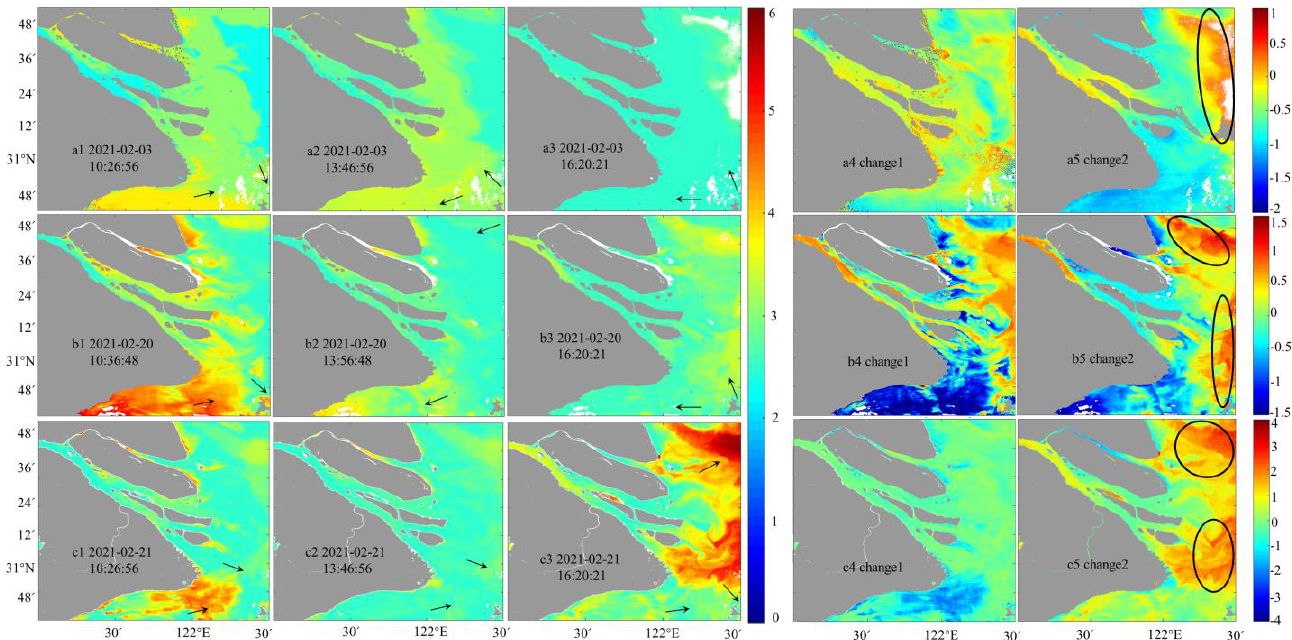
Figure 8. ( a1 – c1 ), ( a2 – c2 ), ( a3 – c3 ), ( a4 – c4 ), ( a5 – c5 ): Chl-a and its change at two different times of the day. ( a4 ): ( a2 ) minus ( a1 ); ( a5 ): ( a3 ) minus ( a2 ); ( b4 ): ( b2 ) minus ( b1 ); ( b5 ): ( b3 ) minus ( b2 ); ( c4 ): ( c2 ) minus ( c1 ); ( c5 ): ( c3 ) minus ( c2 ). Black ellipse: area of Chl-a concentration change.